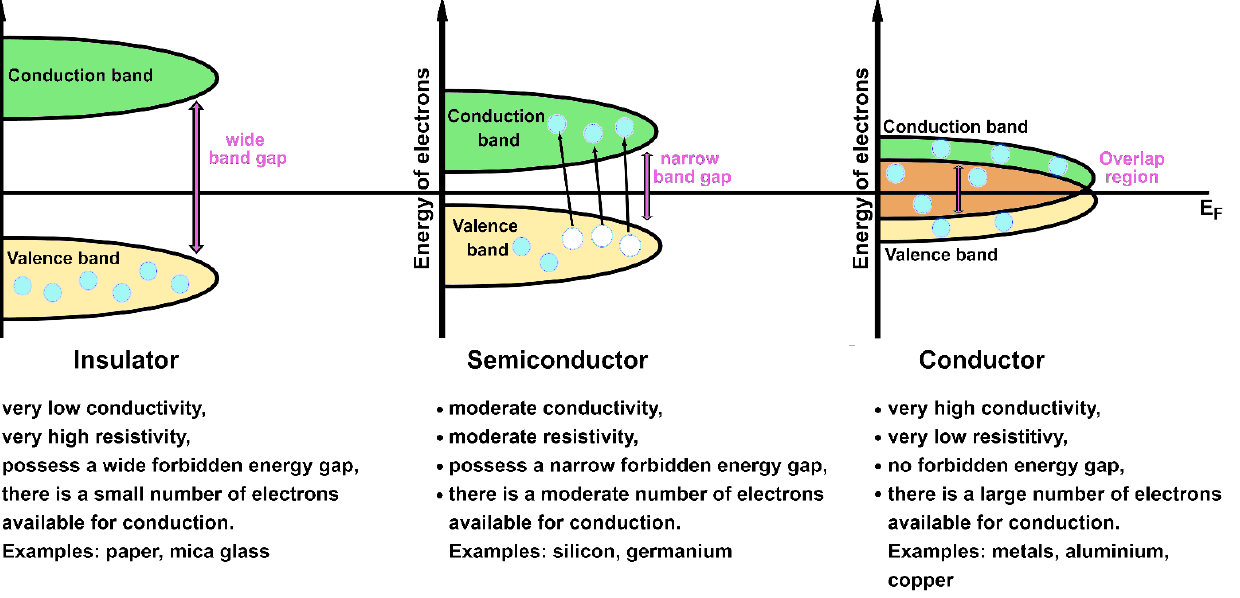
Figure 5. Simple sketch of the differences between insulators, semiconductors and conductors.